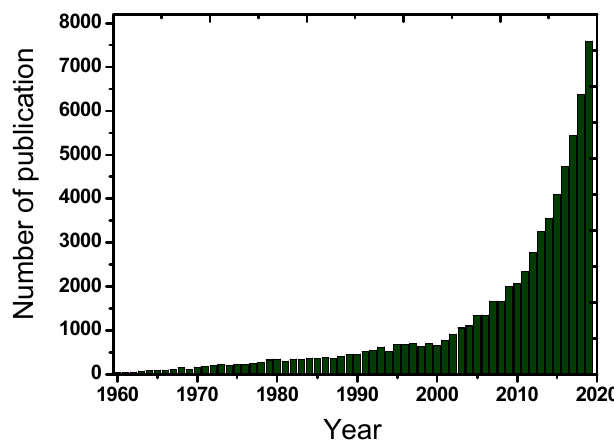
Figure 2. Number of yearly published scientific articles about emerging contaminants, as can be found from a relevant literature search in Science Direct.